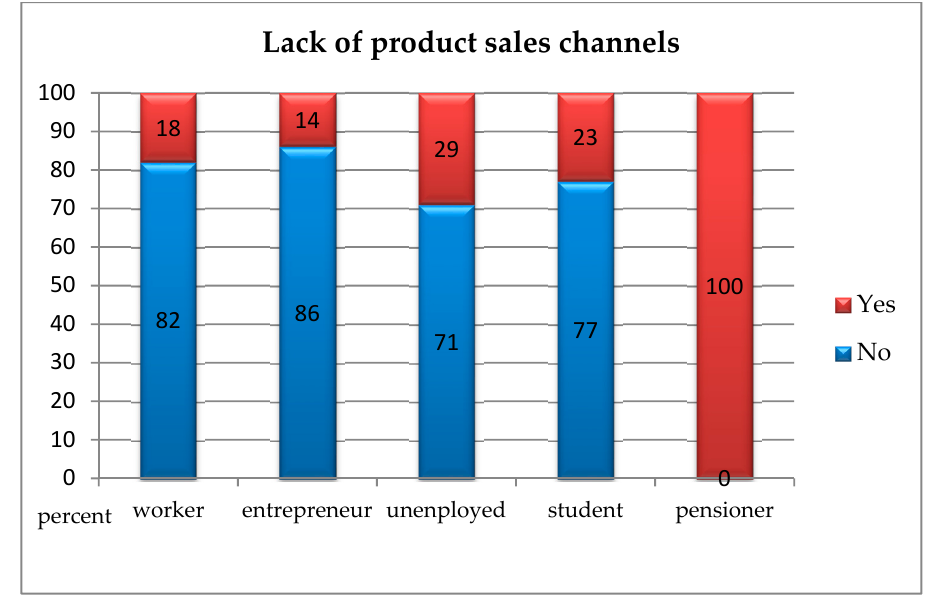
Figure 4. The absence of sales channels as a current problem with the market for environmental goods according to people with a different social status.